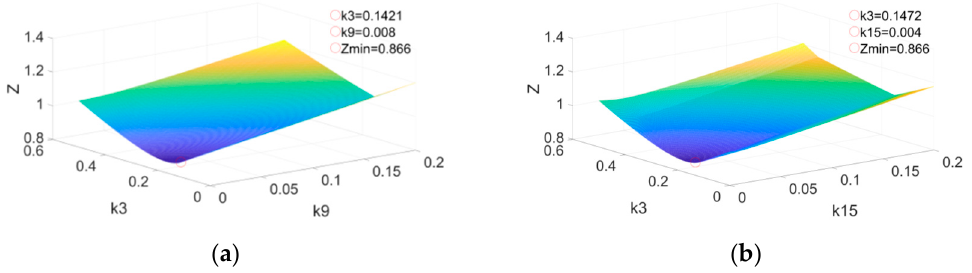
Figure 6. Amplitude distribution of composite waves under multi-component zero-order harmonics ( a ) 3rd and 9th harmonics; ( b ) 3rd and 15th harmonics.